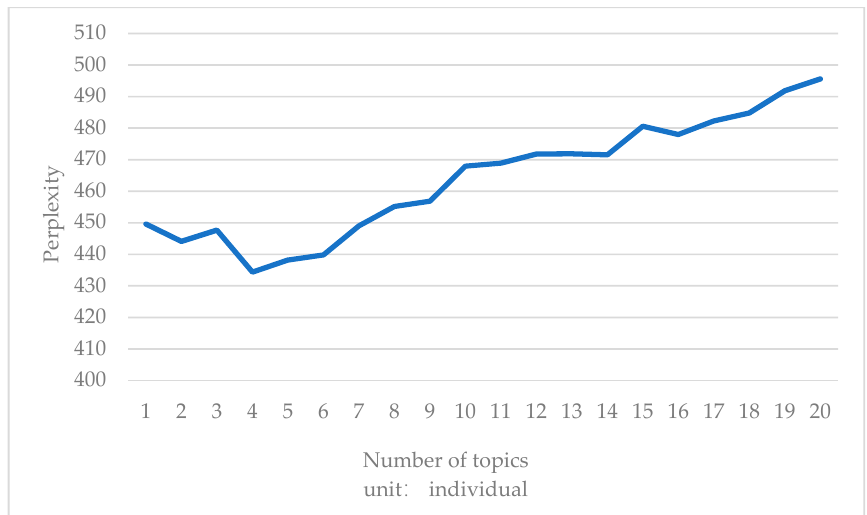
Figure 4. Perplexity of the number of topics before COVID-19.